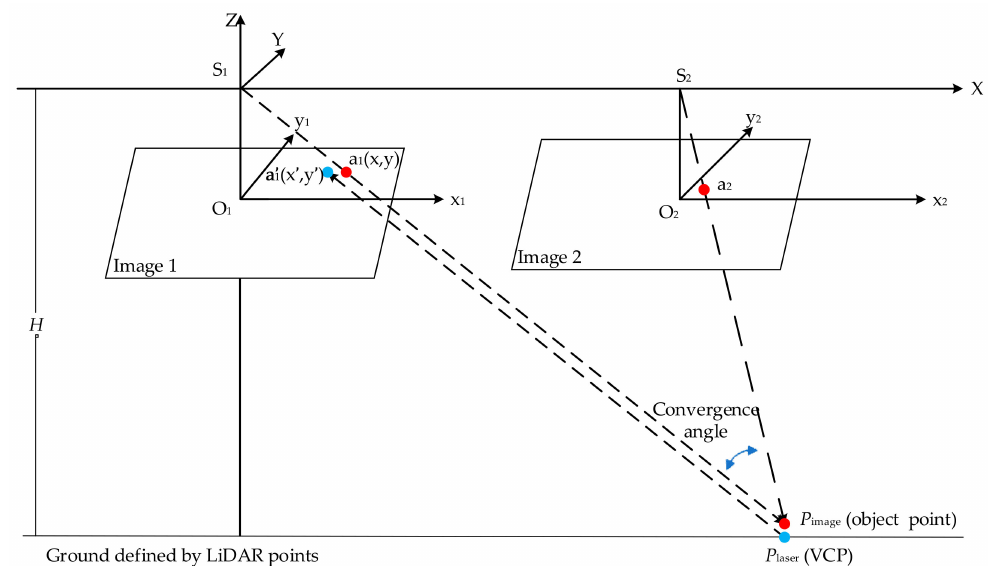
Figure 3. The distance between a 1 and a (cid:48) : S 1 and S 2 are the spatial positions of the projection center of 1 the camera at the moment of acquiring Images 1 and 2. H is the altitude of the